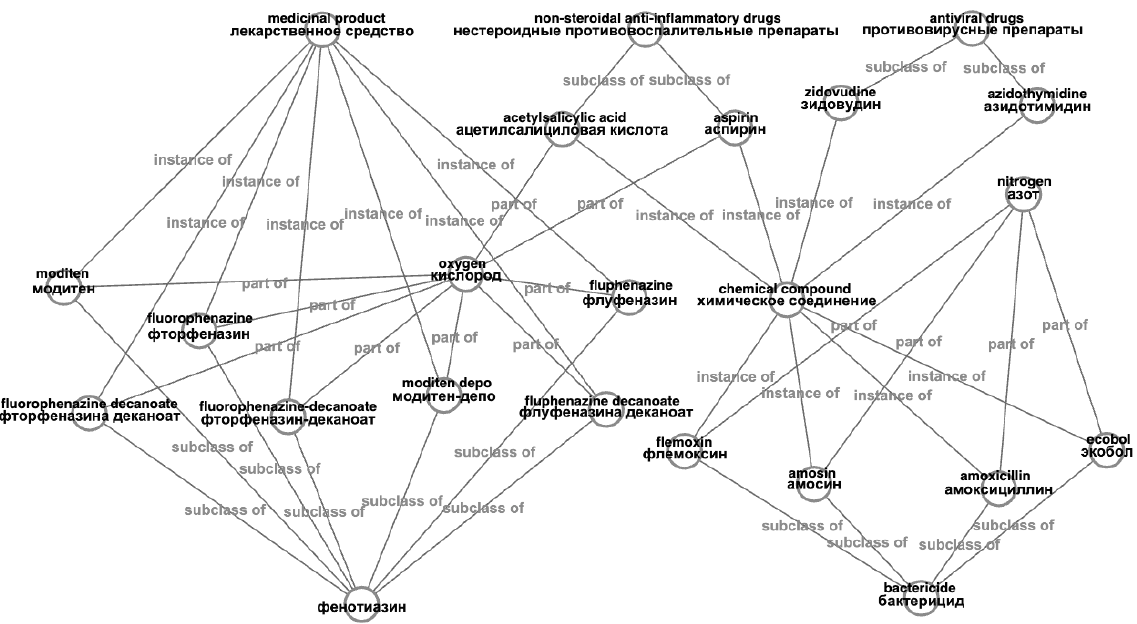
Figure 11. Examples of entities and their relationships in a medical knowledge base at close exami- nation.